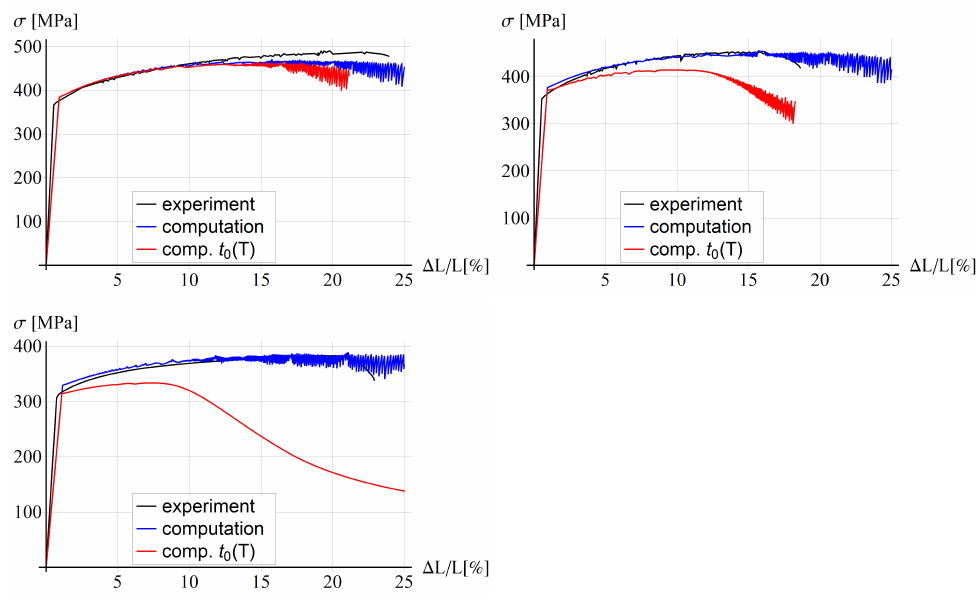
Figure 6. Stress vs. relative extension for thermo-visco plastic model with gradient enhacement for 25 ◦ C ( left , top ), 100 ◦ C ( right , top ), 200 ◦ C ( left , bottom